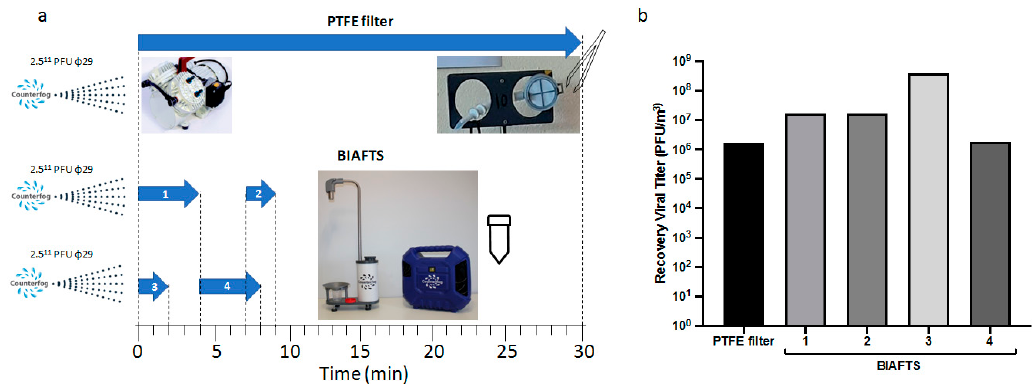
Figure 2. Bacteriophage ɸ 29 aerosols recovery in calibration tests in a 25 m 3 room. Artificially generated bacteriophage ɸ 29 aerosols are captured using PTFE filtration-based sampler and BIAFTS. ( a ) Sampling timeline after the three ɸ 29 dispersion experiments. ( b ) Viral titer recovered in each of the air samples (PFU/m 3 ).